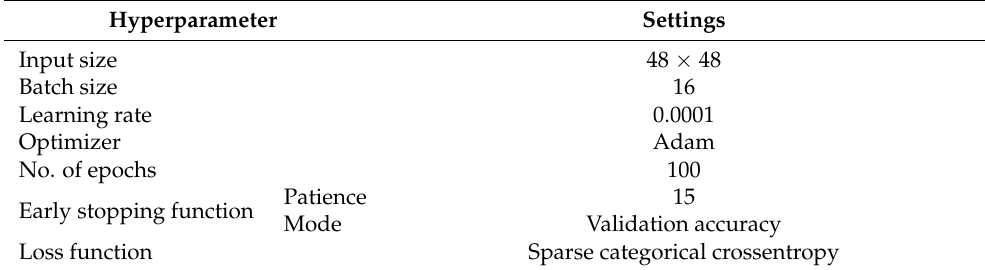
Table 2. Settings for pre-work